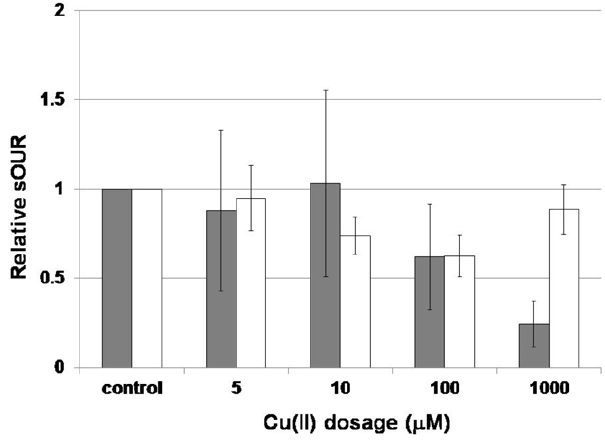
Figure 2. Impact of Cu(II) exposure on relative sOUR values, normalized to control values in stationary and exponential phase N. europaea cultures. Error bars depict standard deviation based on duplicate oxygen uptake rate measurements and cell counts from ten replicate counting chamber wells.